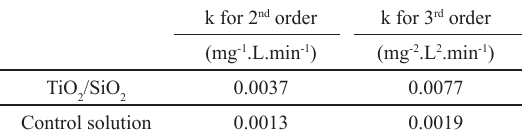
/SiO and control solution 2 2